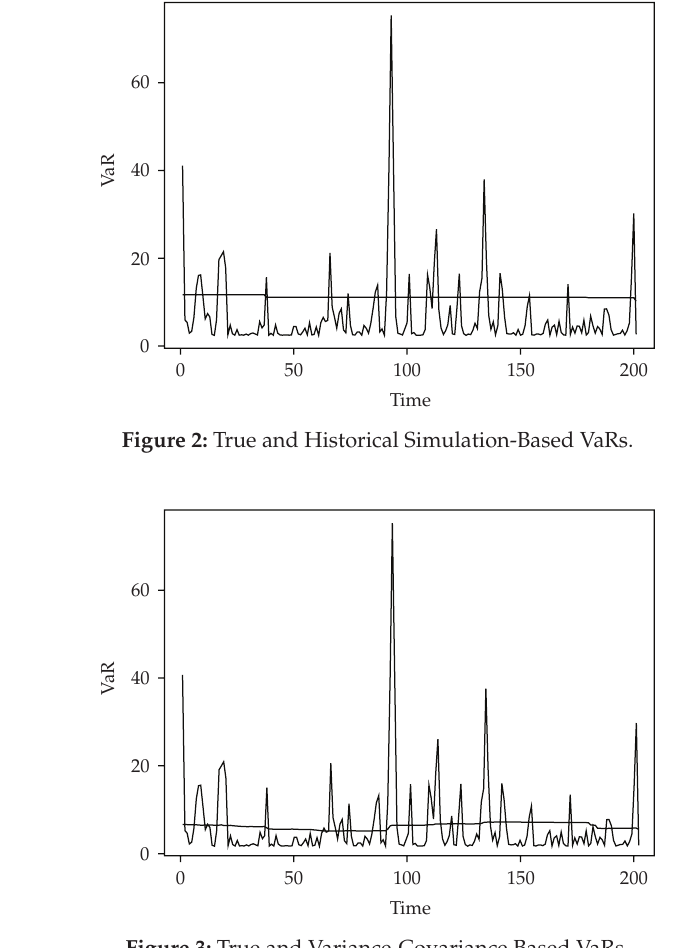
Figure 3: True and Variance-Covariance Based VaRs.